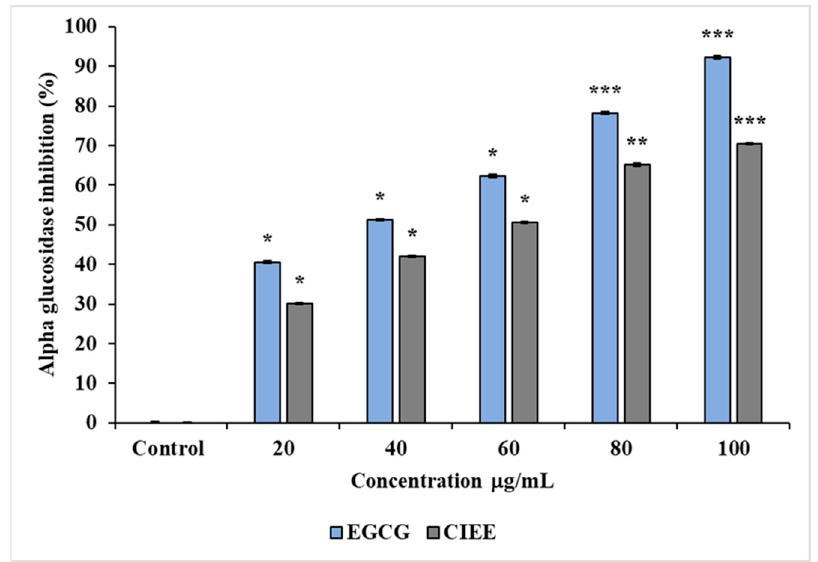
Figure 5. The effect of ethanolic extract of C. incana on α -glucosidase activity. CIEE: Calamintha incana ethanolic extract, EGCG: epigallocatechin gallate (positive control). Data denoted as the mean ± SD (N = 3). * p < 0.05, ** p < 0.01, *** p < 0.001 vs. untreated enzyme (control) (ANOVA, Tukey’s post hoc test).